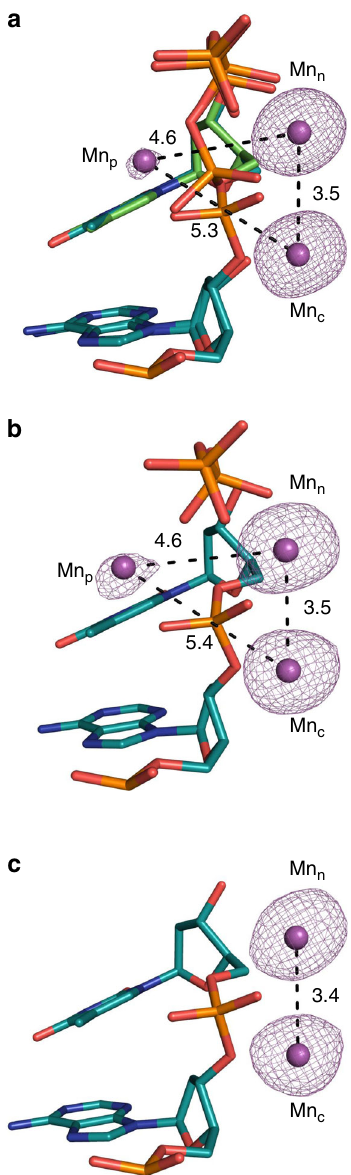
Fig. 6 Anomalous density map overlayed on structures of the ( a ) RS, ( b ) PS, and ( c ) PS* generated by Mn 2+ -mediated anomalous dispersion. PS* refers to an extended soak (960 min) showing the product metal and PP i have dissociated, but the catalytic and nucleotide metals remain bound. Anomalous density is shown as a pink mesh at 5 σ , while the Mn 2+ atoms are displayed as magenta spheres . The incoming nucleotide is shown in green stick representation, while DNA is shown in cyan . Distances (Å) between metals are labeled and indicated by